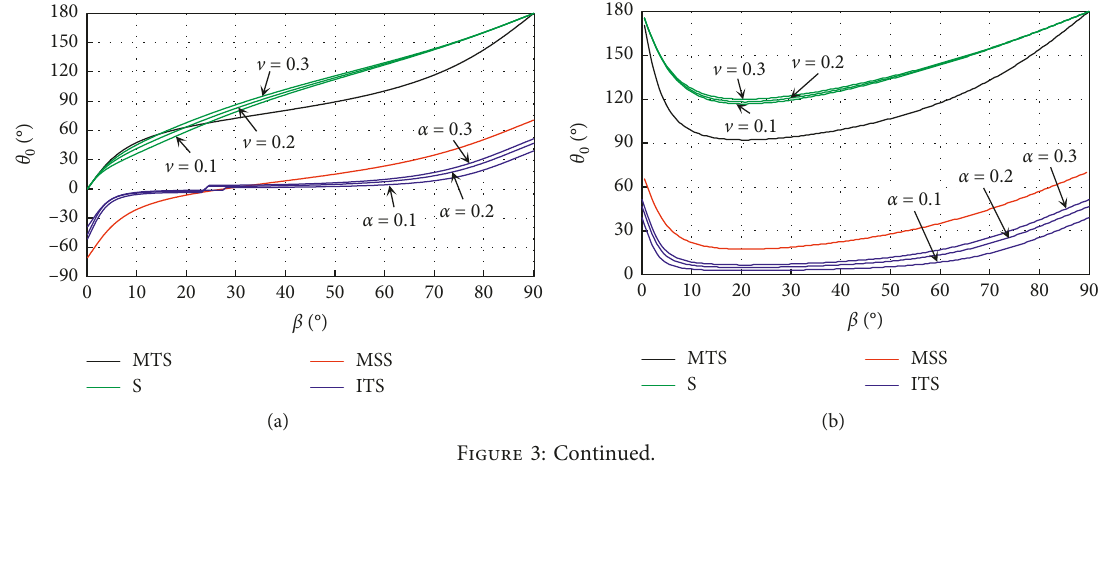
Figure 2: Dimensionless stress field of mode I-II crack: (a) mode-I crack with friction, σ (c) mode-II